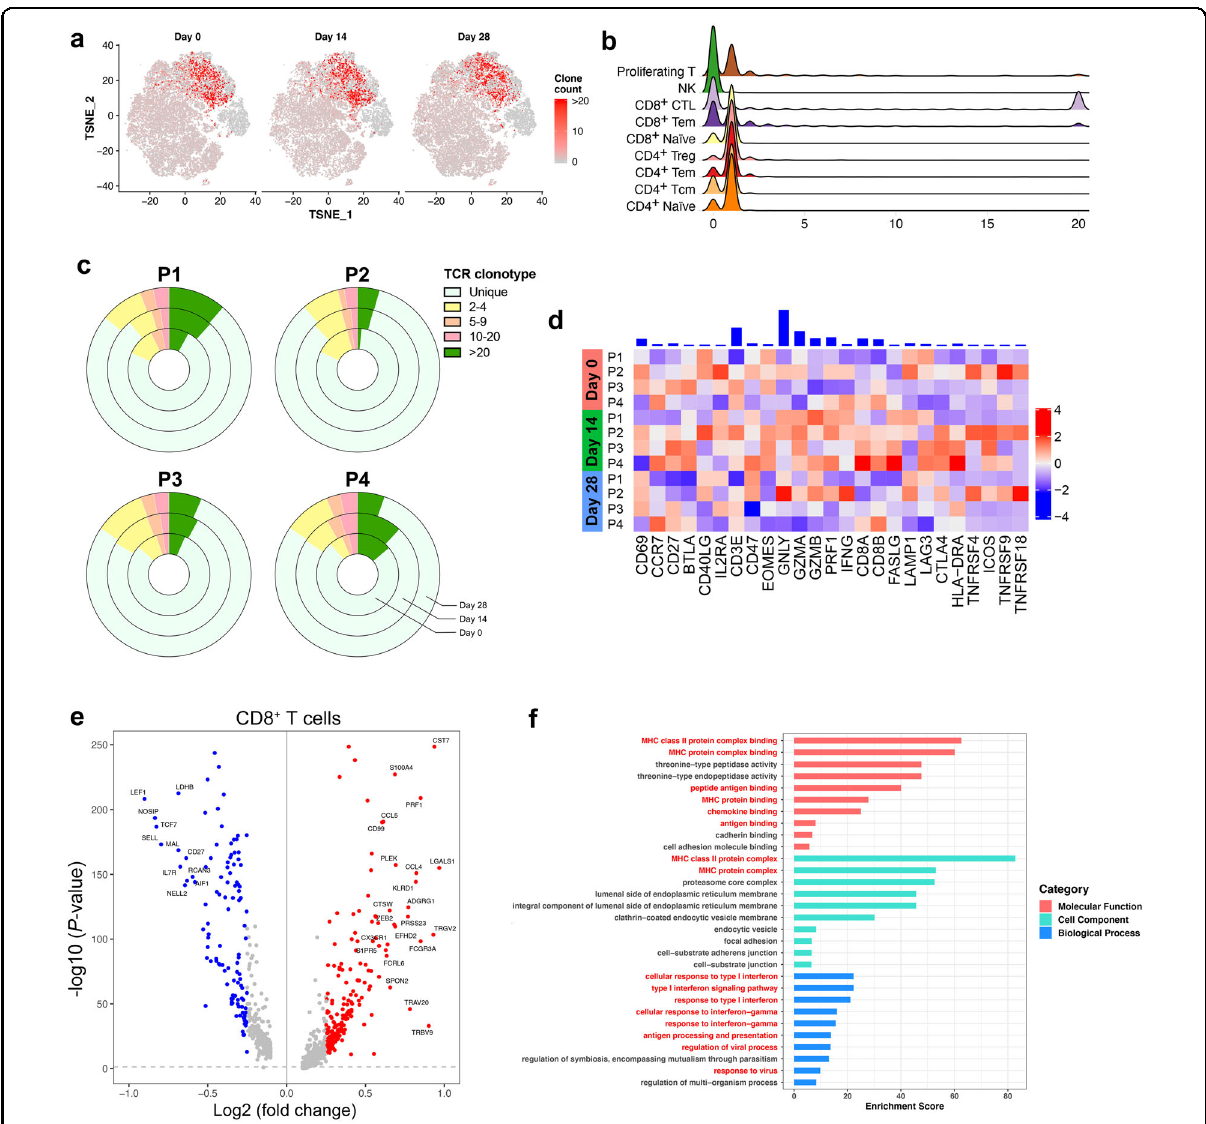
Fig. 5 Dissection of T cells and TCR repertoire. a t -SNE showing expanded TCR clones ( n ≥ 2) in the total T cells indicated by timepoints. b Counts of expanded TCR clones in T cell subtypes. c The pie plot showing the TCR clone differences across the different timepoints and individuals. d Heatmap of z-scored mean expression of T cell activation signature (de fi ned as the normalized mean expression of genes in the activation signature in Supplementary Table S4) across T cells from each participants and timepoints. Top, bar plot of total expression of each gene, across all patients. Expression of T cell activation signature shows variability among individuals. e The volcano plot showing the DEGs between CD8 + T cells with expanded and unexpanded TCR clones at day 14 post-vaccination. Genes with greatest fold changes and signi fi cant P values were annotated in the plot. f The enriched GO terms of the DEGs between T cells with expanded and unexpanded TCR clones at day 14 post-vaccination. P value was derived by a hypergeometric